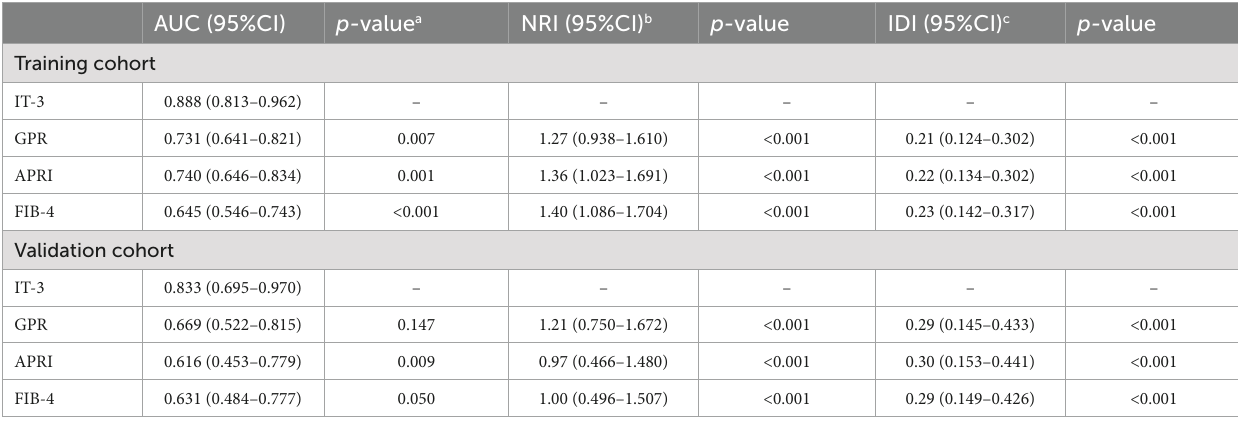
TABLE 3 Discrimination of the IT-3 model and other non-invasive